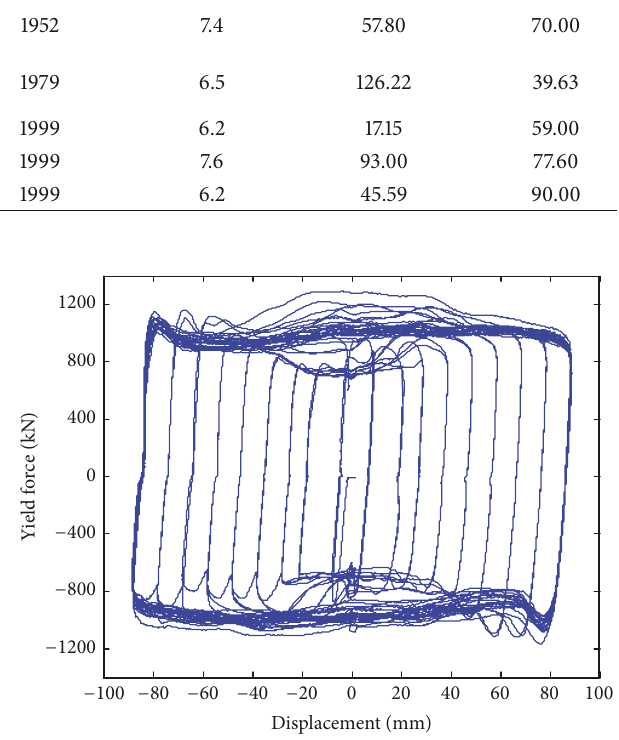
Figure 17: Experiment result of